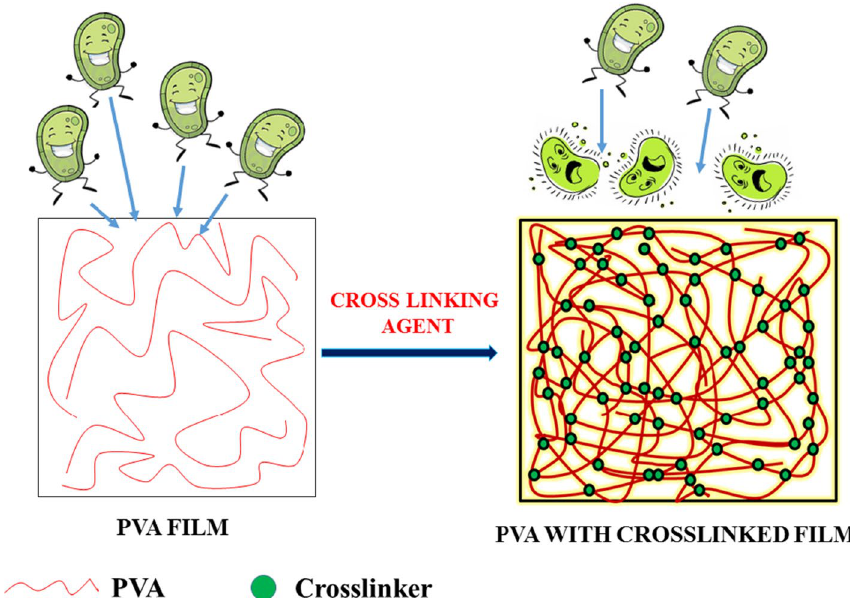
Fig. 10 Schematic represen- tation comparing antibacte- rial activity of pristine PVA/ cross-linked film with different carboxylic